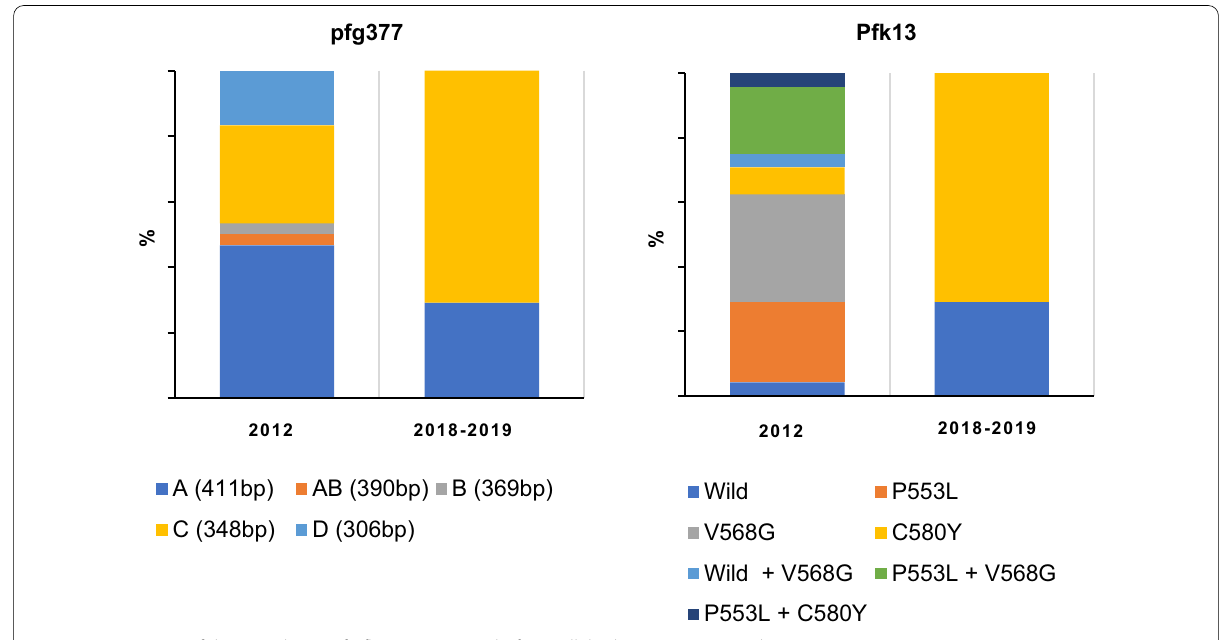
Fig. 3 Comparison of the prevalence of Pfk13 mutants and pfg337 alleles between 2012 and